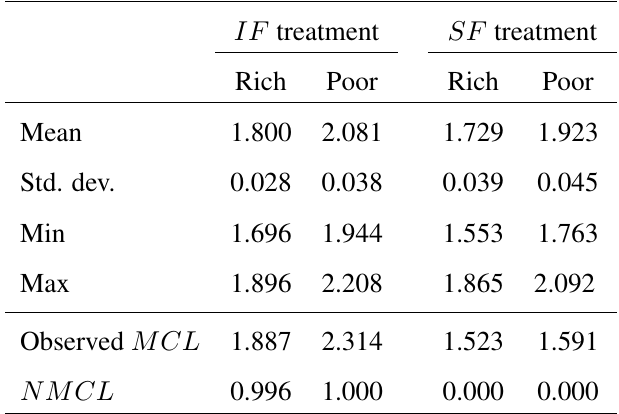
Table 3 . Randomly generated distributions (based on 30,000 random contribution sequences) and position of the observed MCL in the corresponding distribution. IF treatment SF treatment